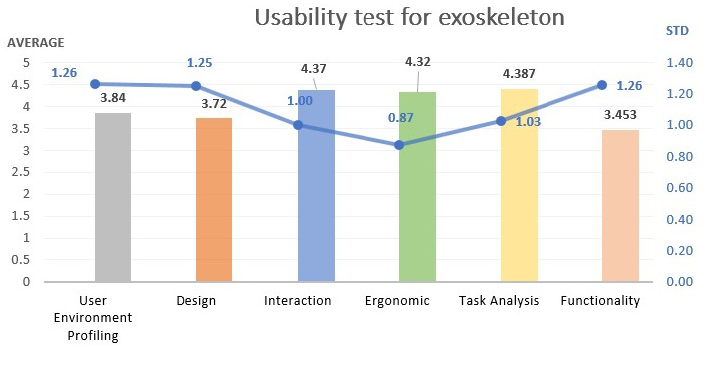
Figure 12. Results of the usability